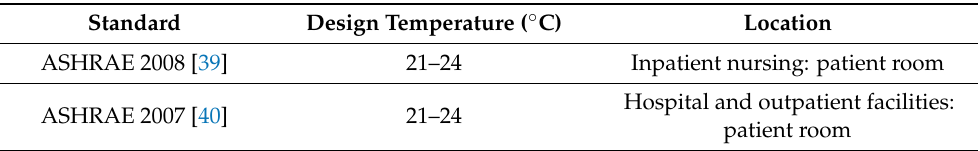
Table 6. Thermal comfort ranges according to the ASHRAE Standards.